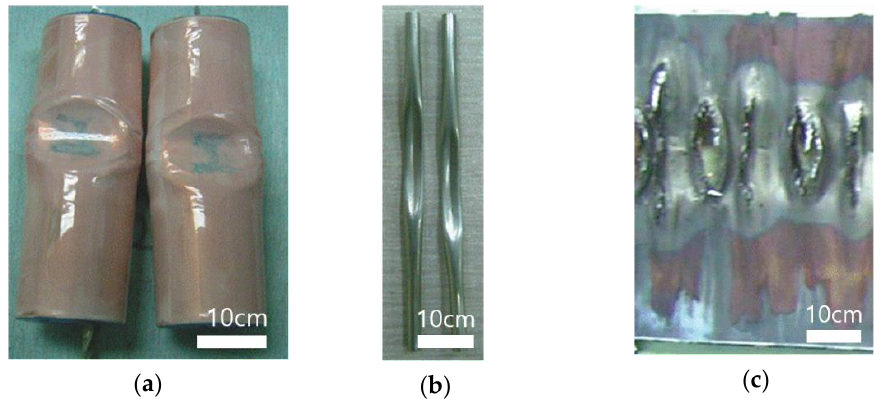
Figure 1. ( a ) Deformed cells after the impact test. ( b ) Deformed center-pins. ( c ) A damaged elec- trode.